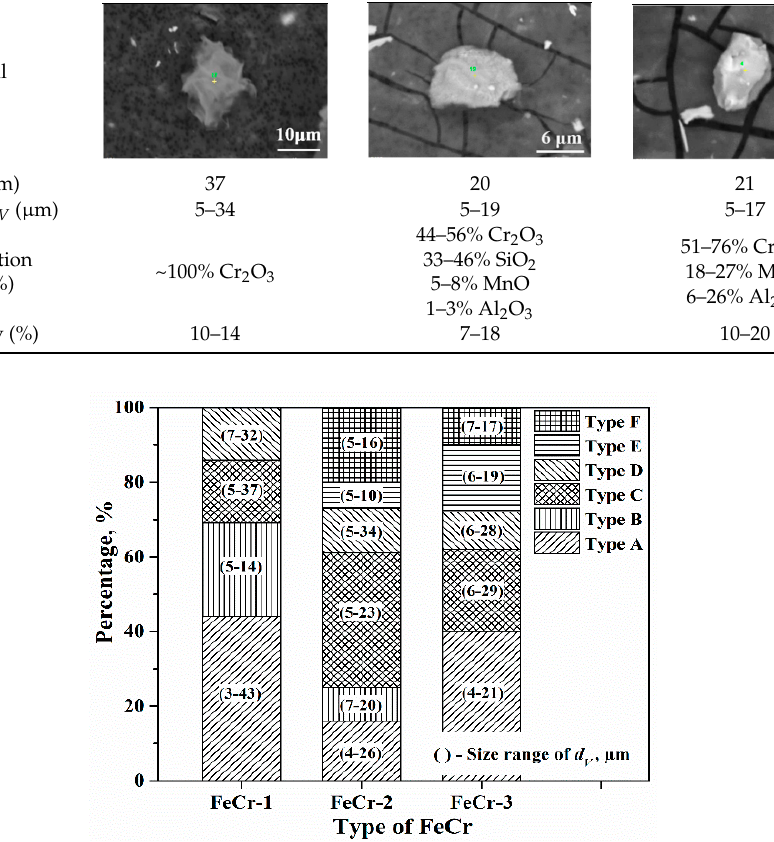
Figure 5. Frequencies and size ranges of different types of inclusions in three different FeCr alloys.